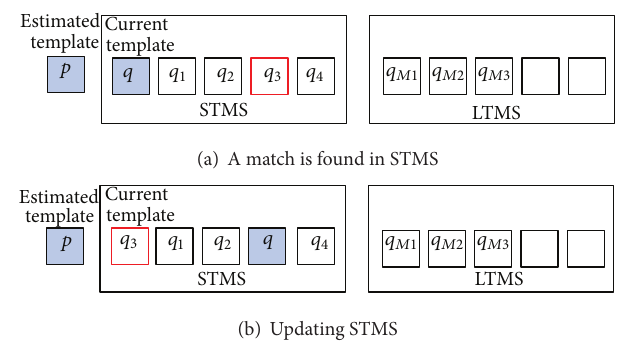
Figure 6: Illustration of updating process in STMS.